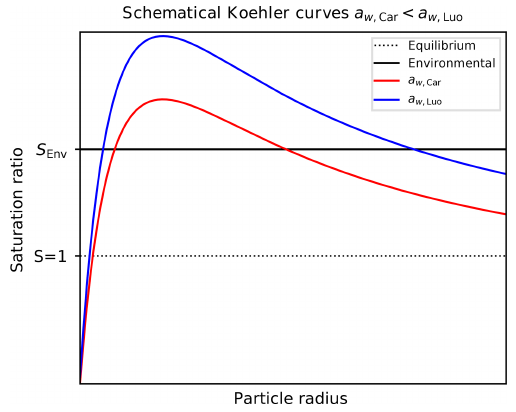
Figure 13. Schematic Köhler curves (red and blue curve) for fixed environmental temperature and chemical composition of the solu- tion particle but computed using different representations of the water activity. Here, the assumption a w , Car < a w , Luo is adopted; the reversed estimate is obtained by interchanging the role of the red and the blue curve. The solid black line indicates a fixed en- vironmental humidity, represented by the environmental saturation ratio S Env . The dotted black line refers to